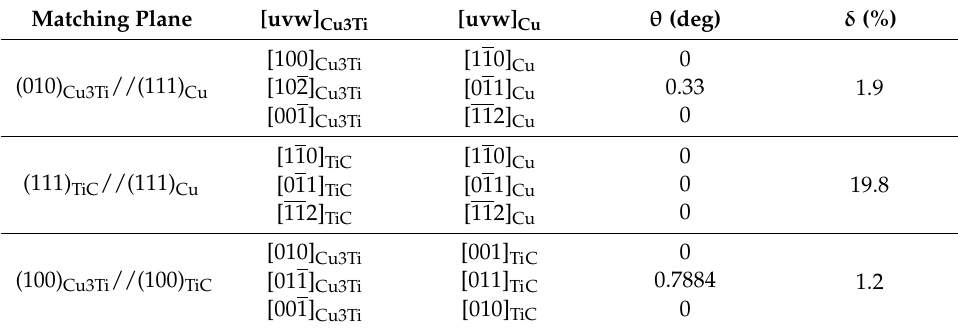
Figure 10. Crystallographic relationship. ( a ) (010) Cu 3 Ti and (111) Cu faces, ( b ) (111) TiC and (111) Cu faces. Table 2. The calculated lattice misfit between Cu 3 Ti and α -Cu phases. Matching